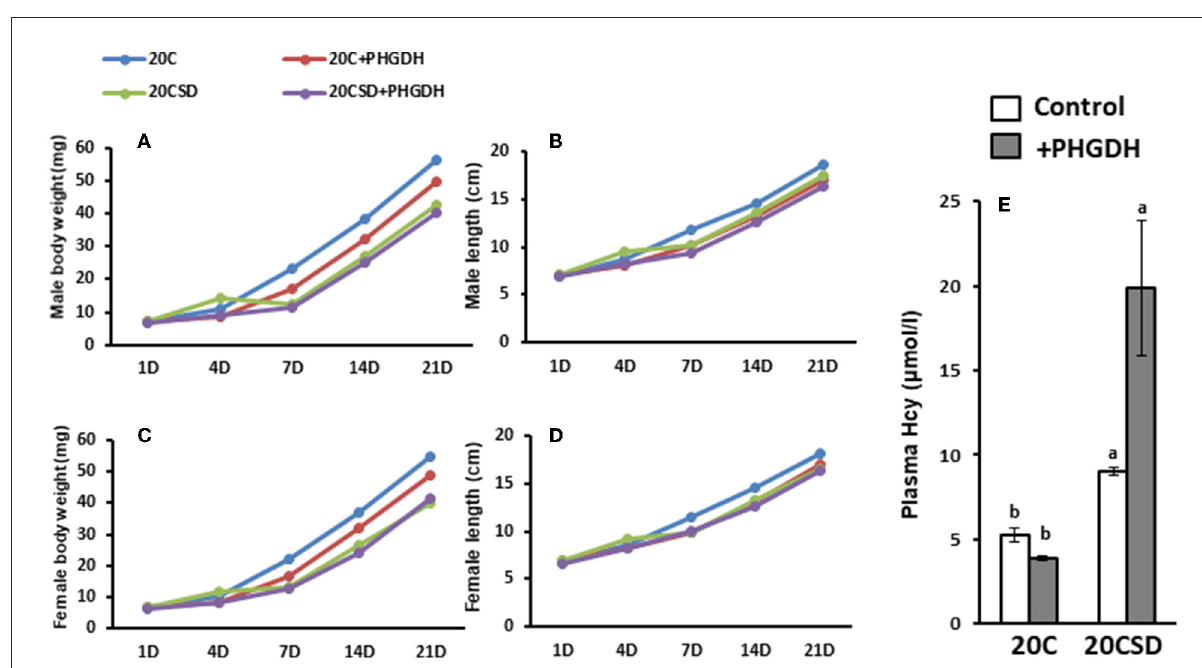
FIGURE9 Effects of Low plasma serine and normal selenoprotein concentration in pregnant rats on the physiologic development and health of offsprings (experiment 2). Each value is the mean ± SEM, n = 8. Means in a panel without a common letter differ, P < 0.05. See the legend of Figure 5 for other